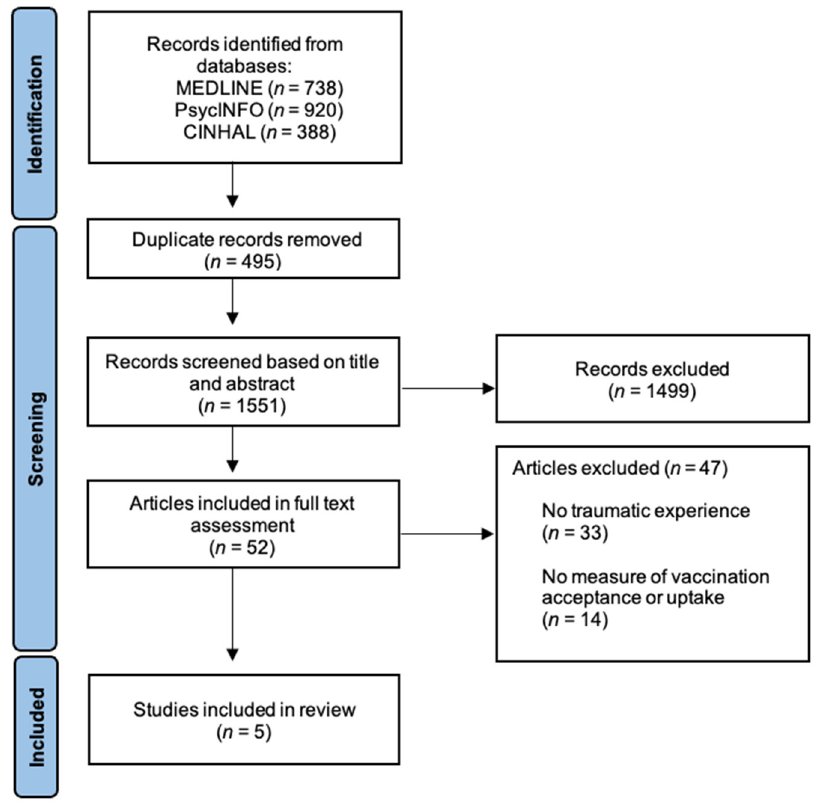
Figure 1. Flowchart of selection process of articles included in the review.